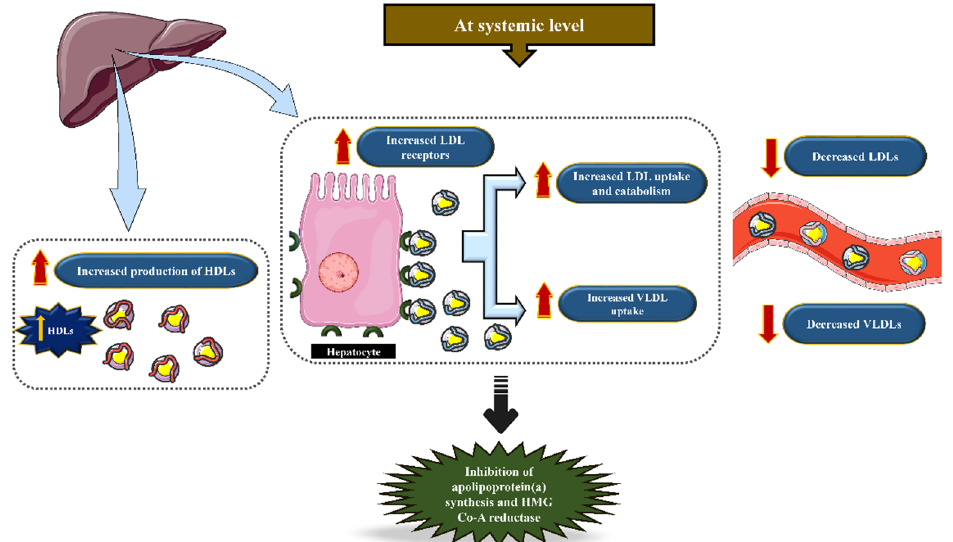
Figure 3. The effects of statins at systemic levels. Statins increase the expression of LDL receptors on hepatocytes to increase LDL uptake and catabolism, leading to a systemic decrease in LDLs, vLDLs, and the production of HDL.